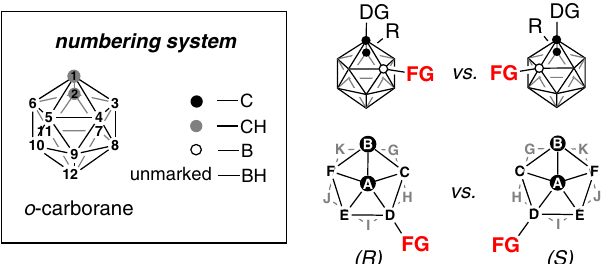
Fig. 1 The inherent cage B(4/5) chirality of 1,2-substituted- o -carboranes. The presence of a substituent at the position 4/5 results in the chirality of the molecule. The observer looks onto the pentagonal plane of C(2) – B(3) – B(4) – B(5) – B(6) in o -carborane and then examines the position of the substituent according to the Cahn – Ingold – Prelog rule for the determination of the cage